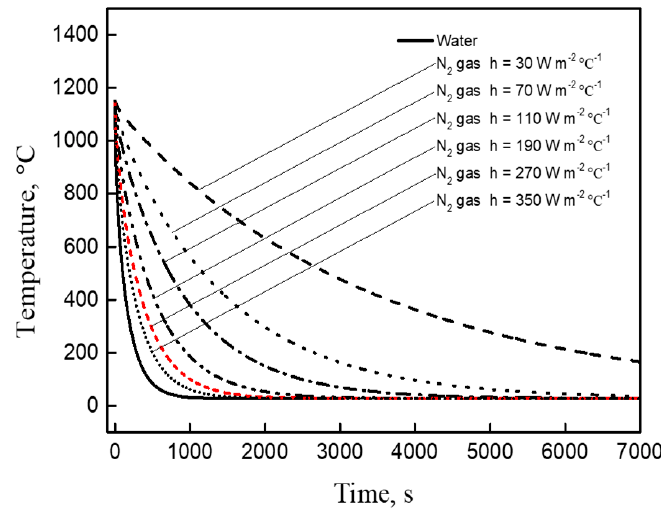
Figure 10. Cooling curves with respect to water and nitrogen gas cooling.